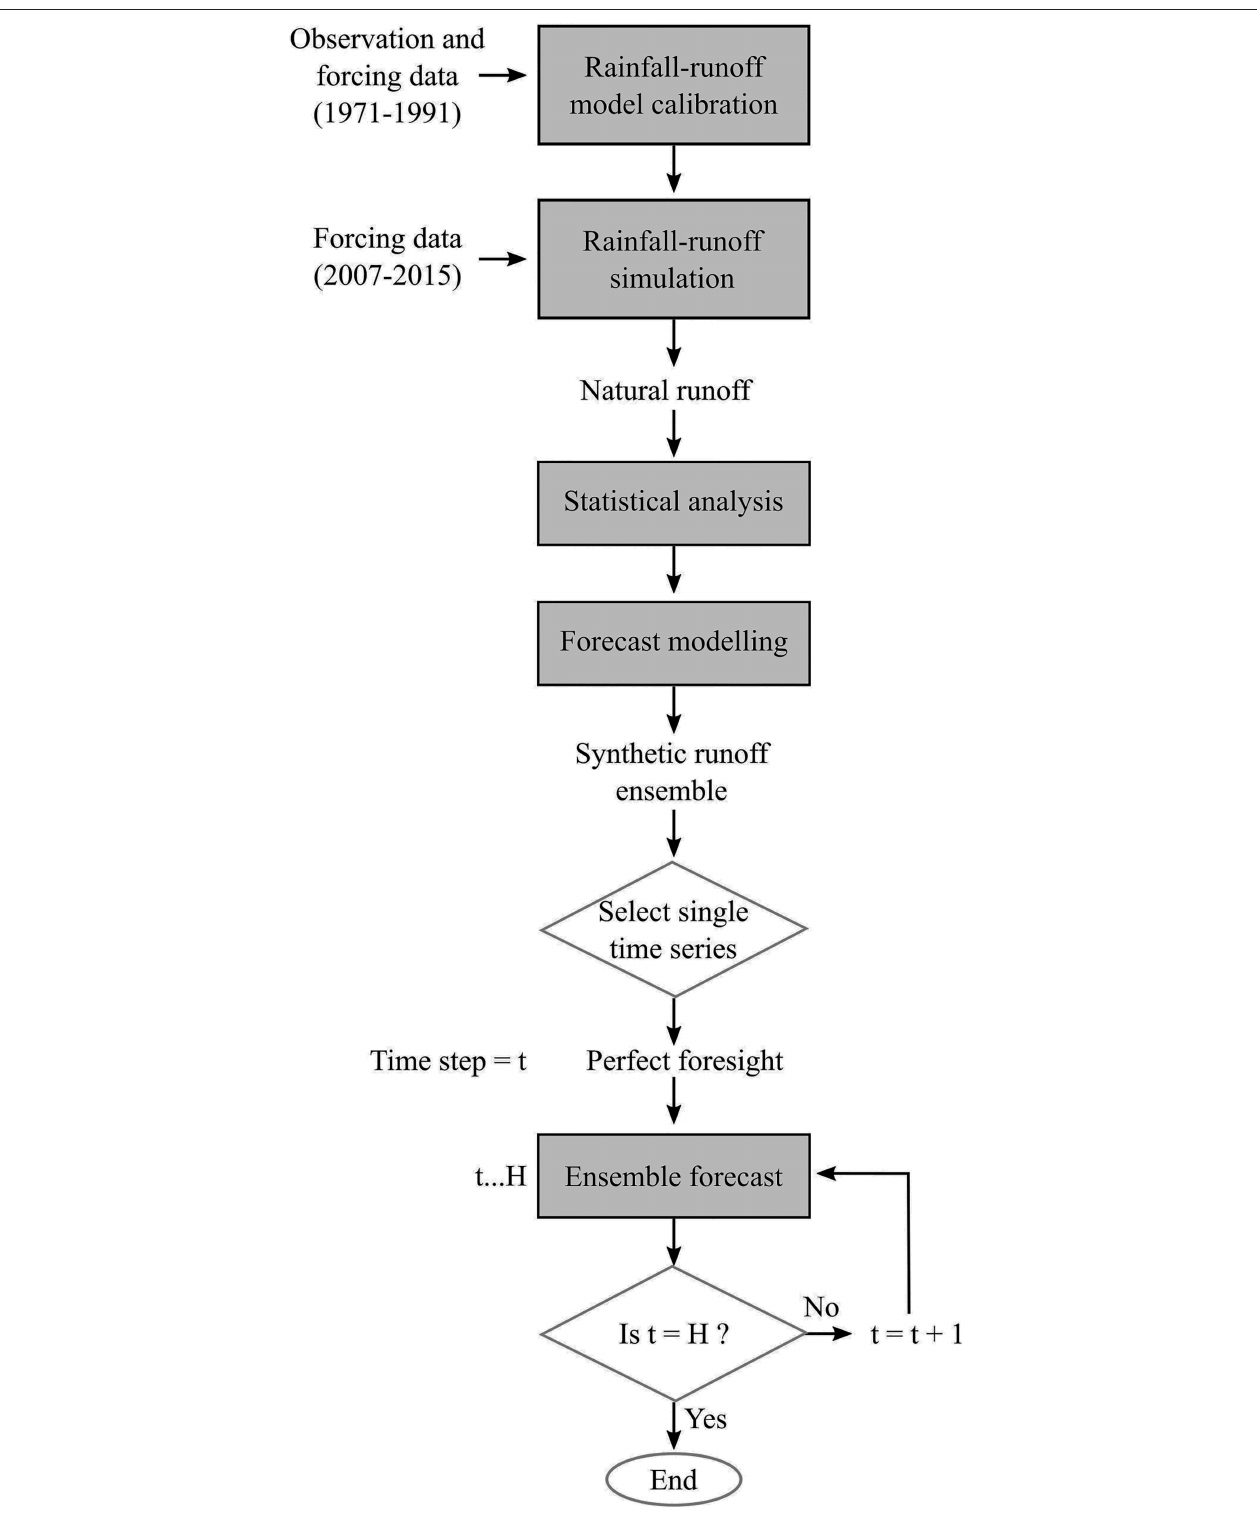
Frontiers in Water |